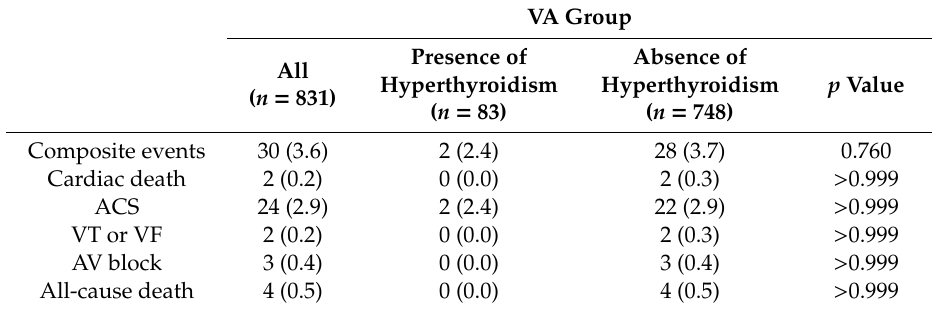
Table 3. Clinical Event Rate of Patients with Vasospastic Angina According to the Presence or Absence of